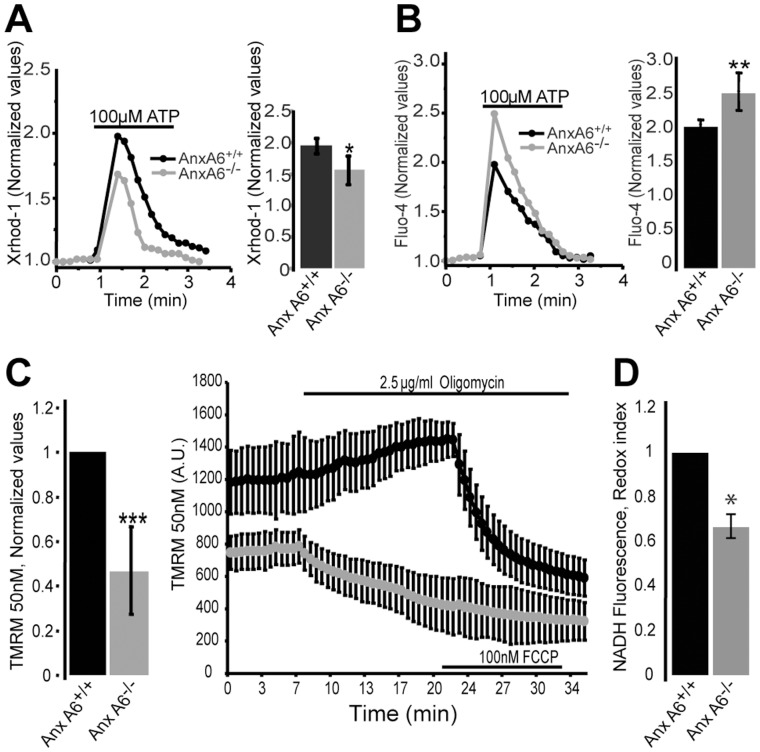
Ca2+ signalling and mitochondrial physiology defects in cells lacking anxA6.(A) Cytosolic Ca2+ transients in AnxA6
+/+ and AnxA6
−/− fibroblasts in response to ATP measured with Fluo-4. The pooled data are shown in the adjacent histograms comparing peak responses. (B) Representative traces of mitochondrial Ca2+ uptake in AnxA6
+/+ and AnxA6
−/− fibroblasts with histogram summarizing relative values assessed with XRhod-1 in response to stimulation with the IP3 generating stimulus ATP (100 mM) in both cell types. (C) ΔΨm in AnxA6
+/+ and AnxA6
−/− ear fibroblasts was measured in cells equilibrated with 50 nM TMRM under resting conditions. The TMRM intensity, normalized to that of the AnxA6
+/+ cells demonstrates a reduction in potential in AnxA6
−/− cells. In response to oligomycin, ΔΨm increased in AnxA6
+/+ cells but decreases in the AnxA6
−/− cells, suggesting that ΔΨm is maintained by a reversal of the F1-FoATPsynthase. (D) NADH autofluorescence was measured and consecutive additions of NaCN and FCCP were used to establish the dynamic range of the signal and to normalize the resting state in relation to the maximally reduced and maximally oxidised signals (respectively). The normalized values show that the NADH redox state was more oxidized in AnxA6
−/− cells consistent with a degree of uncoupling.